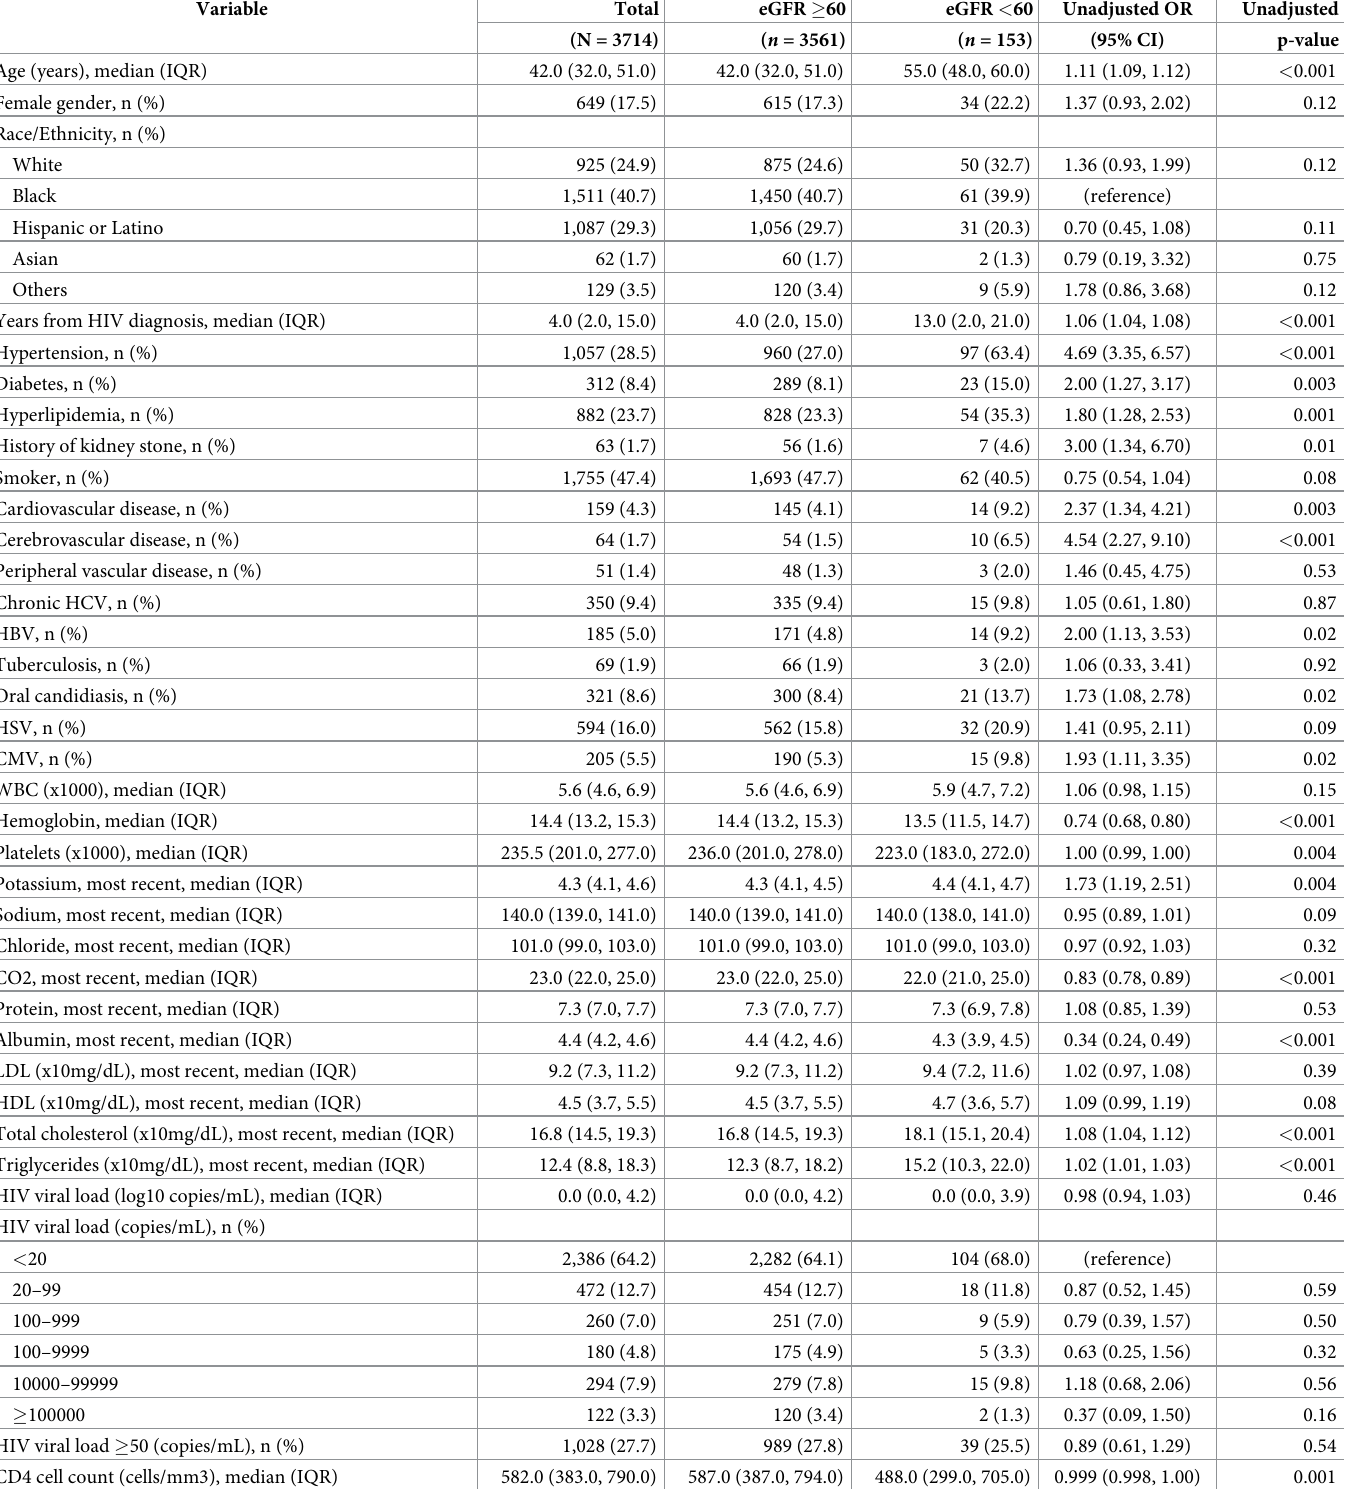
Table 1. Demographics, comorbidities and laboratory parameters, stratified by